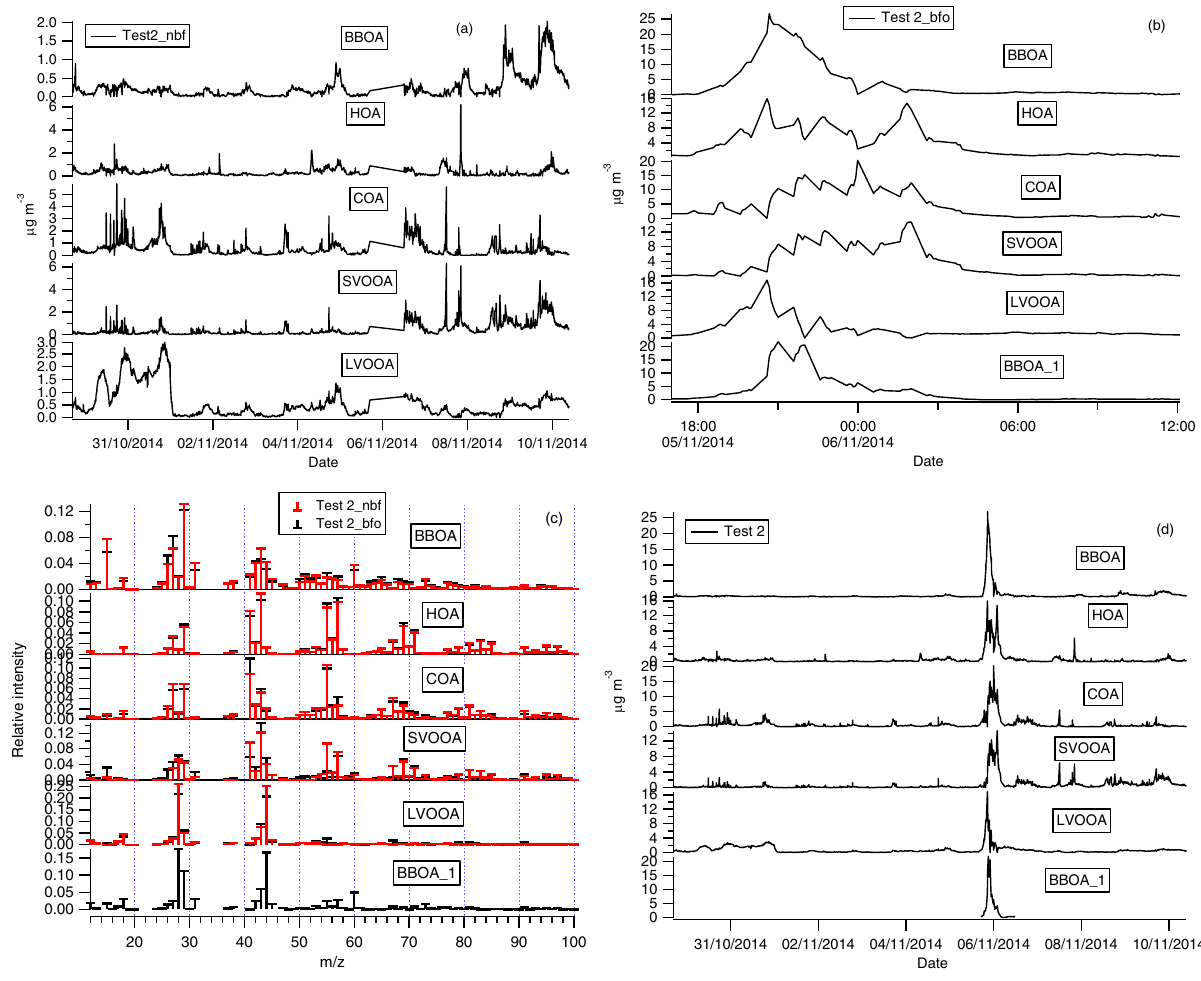
Figure A1. OA sources mass spectra and time series for